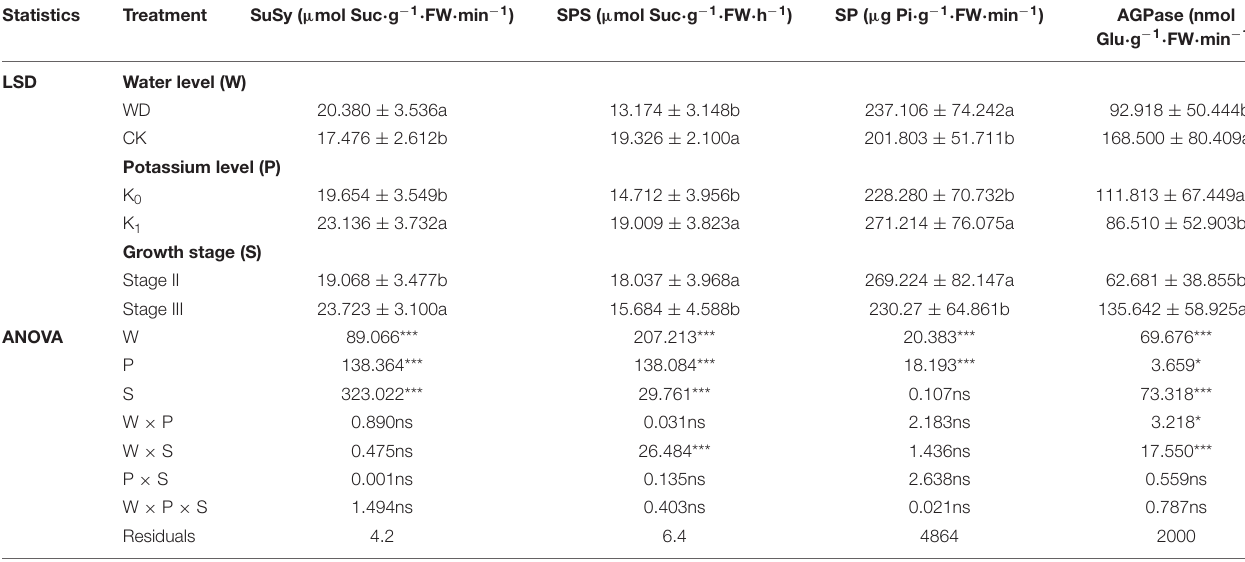
TABLE 3 | Three-way analysis of variance of leaves SuSy, SPS, SP, and AGPase were performed to identify individual and interactive effects of water (2 levels: water deficit and CK), potassium (2 levels: K 0 , K 1 ) and growth stage (2 levels: stage II and stage III) during all growth stages.